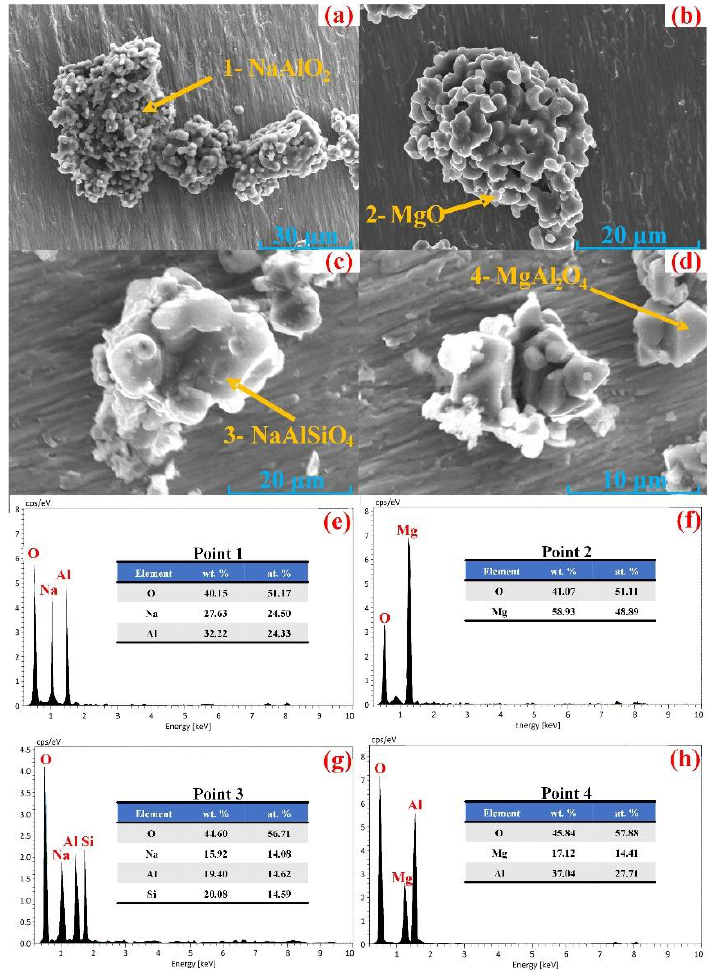
Figure 11. SEM micrographs of the roasting clinkers ( a , b ), leaching residues ( c , d ) and EDS ( e – h ).